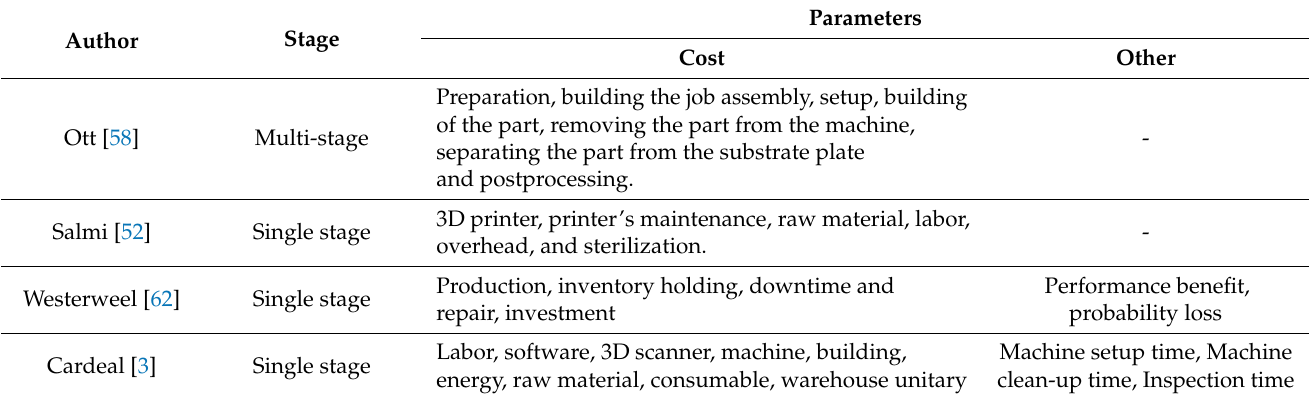
Table 5. Economic